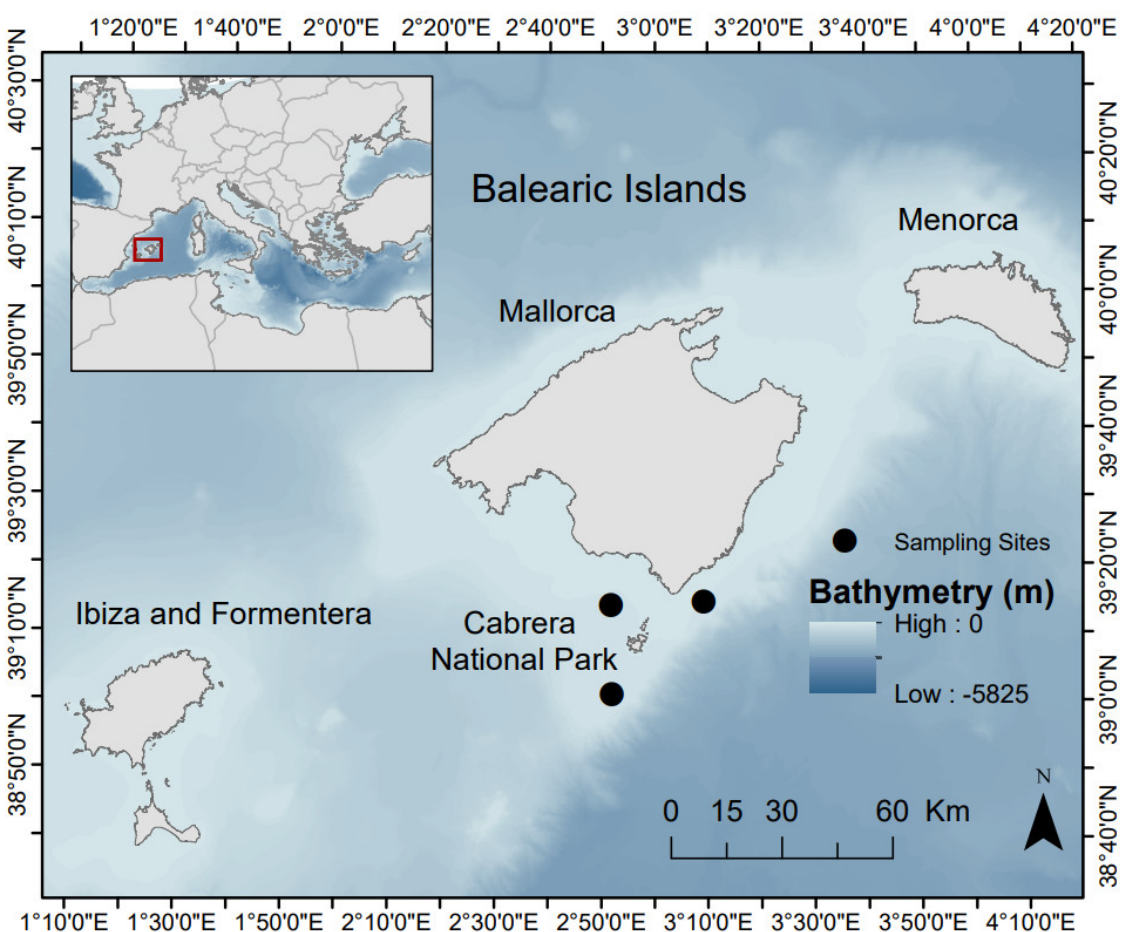
Figure 1. Map of the locations of the sampling sites in the surrounding waters of the Cabrera Archipelago Maritime-Terrestrial National Park. Inset map indicates the location of the sampling area in the Balearic Islands in the western Mediterranean Sea.